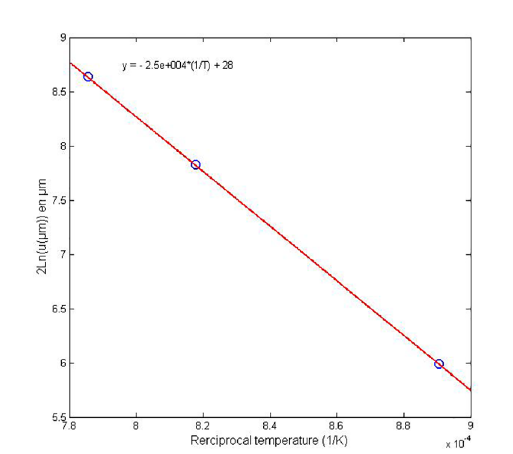
Figure 1. Reciprocal temperature dependence of the boride layer thickness formed on XC38 steels after 2h.